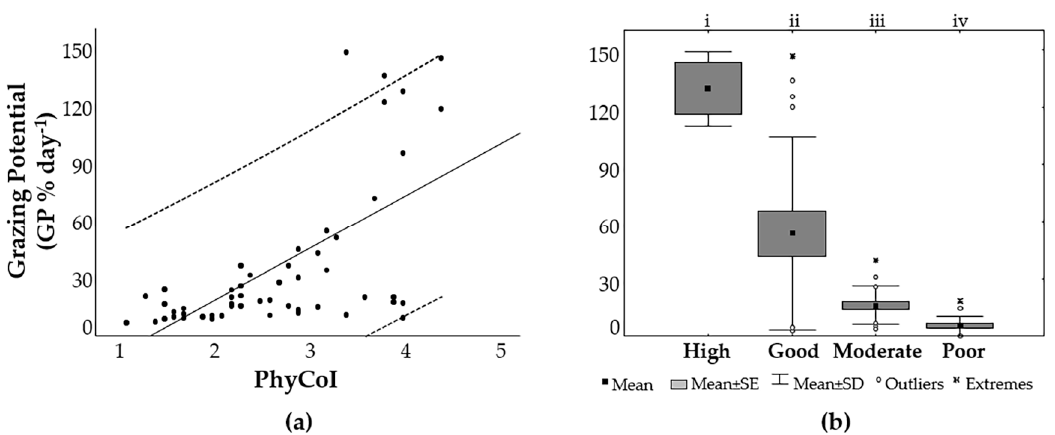
Figure 3. ( a ) Scatter plot of grazing potential (GP) against PhyCoI, solid line indicates the linear regression line and dashed lines indicate 95% prediction limits of the model; ( b ) box plot of grazing potential based on data of plankton communities from the 13 Greek lakes grouped into ecological water quality classes according to PhyCoI. i, ii, iii indicate significant differences (Post-hoc Bonferroni